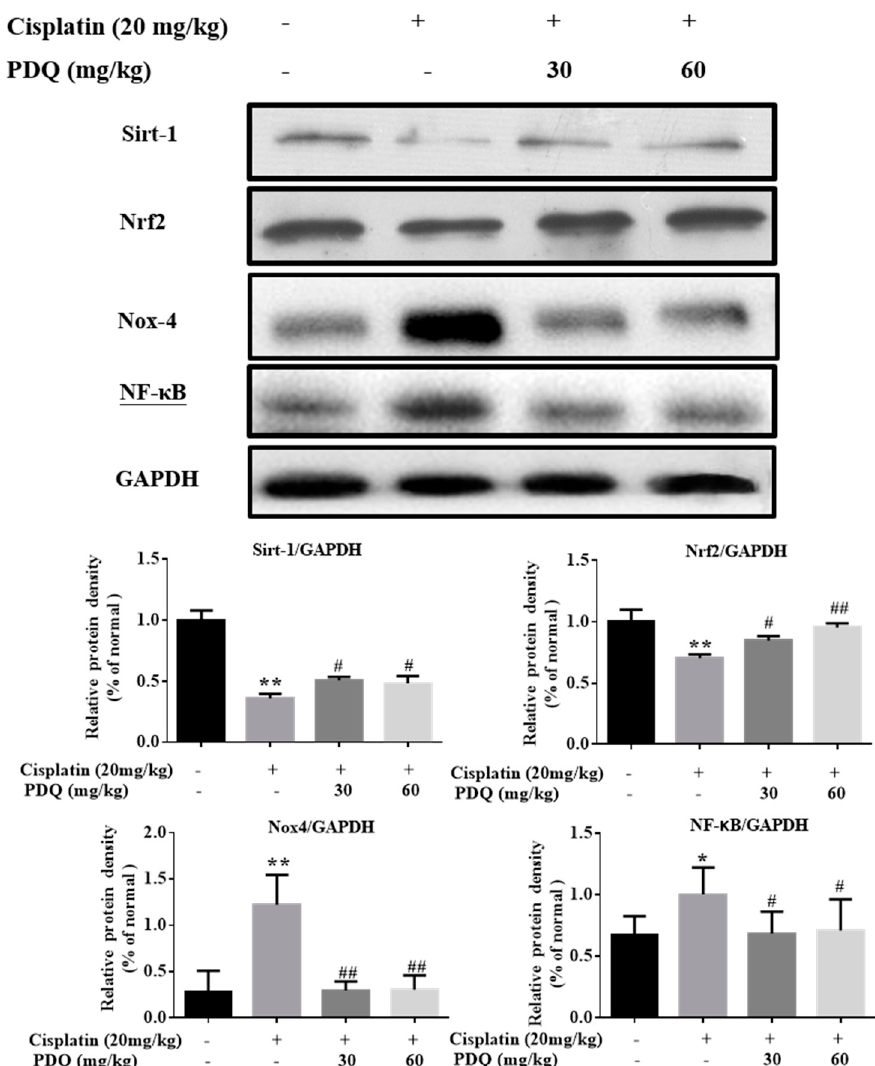
Figure 7. Effects of PDQ on the protein expression of Sirtuin-1 (Sirt-1), nuclear-related factor 2 (Nrf2), Nox-4, and nuclear factor-kappa B (NF- κ B). n = 3, * p < 0.05, ** p < 0.01 vs. normal group; # p < 0.05, ## p < 0.01 vs. cisplatin group.